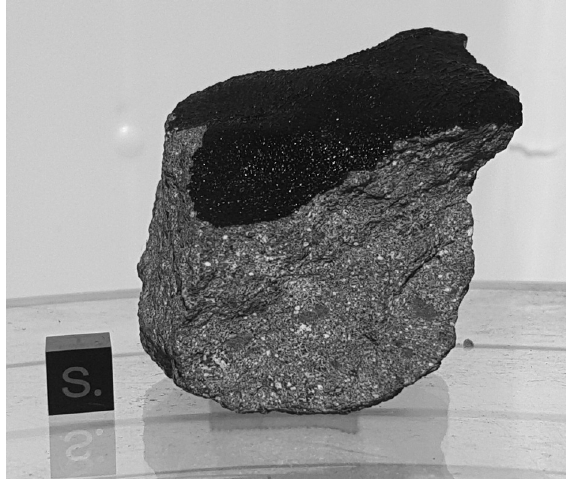
Figure 1 - A cut section of Serra Pelada meteorite. It shows a typical eucrite with a partial, shiny, black fusion crust and a light colored interior with a brecciated texture. Also visible are some cracks and melt veins. Some clasts show clumps of white blades of plagioclase (size of cube 1